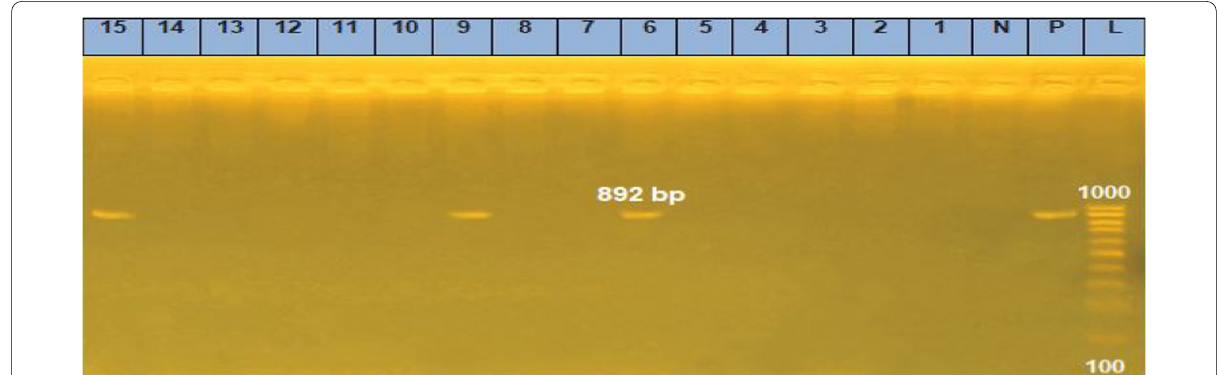
Fig. 8 Agarose gel electrophoresis showing amplification product of 892 bp of KPC . Lane L: Ladder (Marker) 100–1000 bp plus DNA ladder. Lane P : control positive. Lane N : control negative. Lane 1–15 : examined isolates